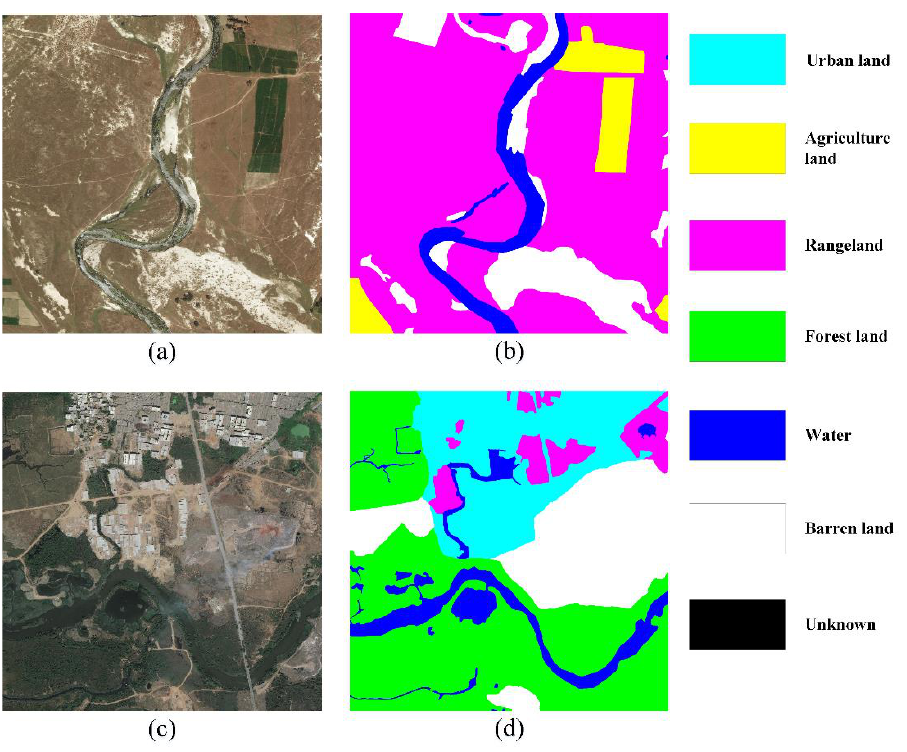
Figure 6. Illustration of DeepGlobe data samples. ( a ) Raw image, ( b ) annotated ground truth of ( a ), ( c ) raw image, ( d ) annotated ground truth of ( c ).